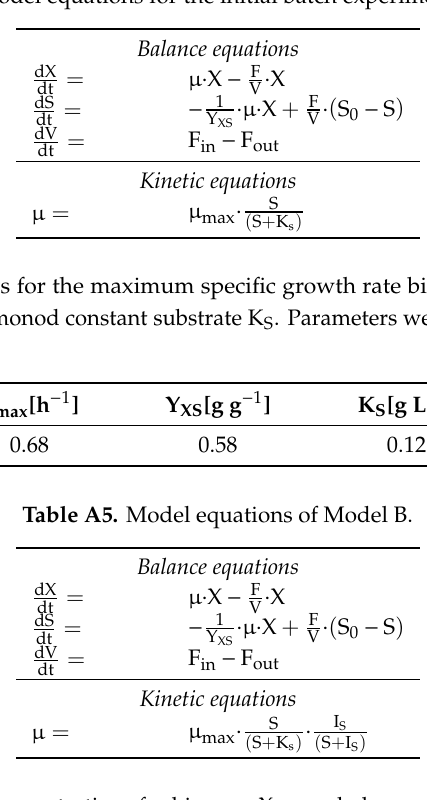
Table A6. Estimated initial concentrations for biomass X init and glucose S init and the estimated model parameters for the maximum specific growth rate biomass µ max , yield coe ffi cient biomass / substrate Y XS , monod constant substrate K S , and substrate inhibition constant I S . fed-batch experiment.